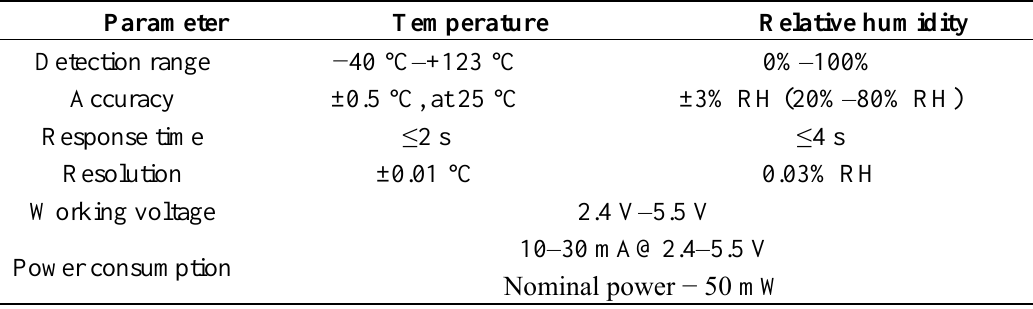
Table 3. Parameters of the temperature the humidity sensor